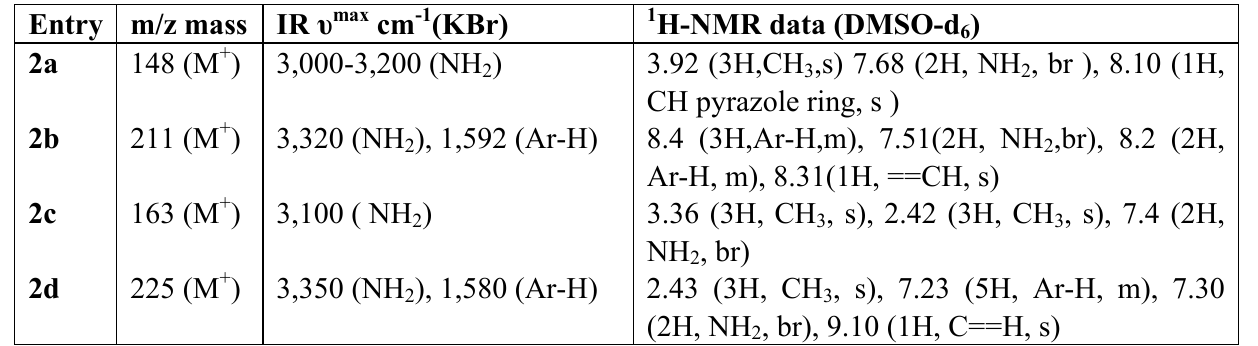
Table 2. Spectral data for 2a-d